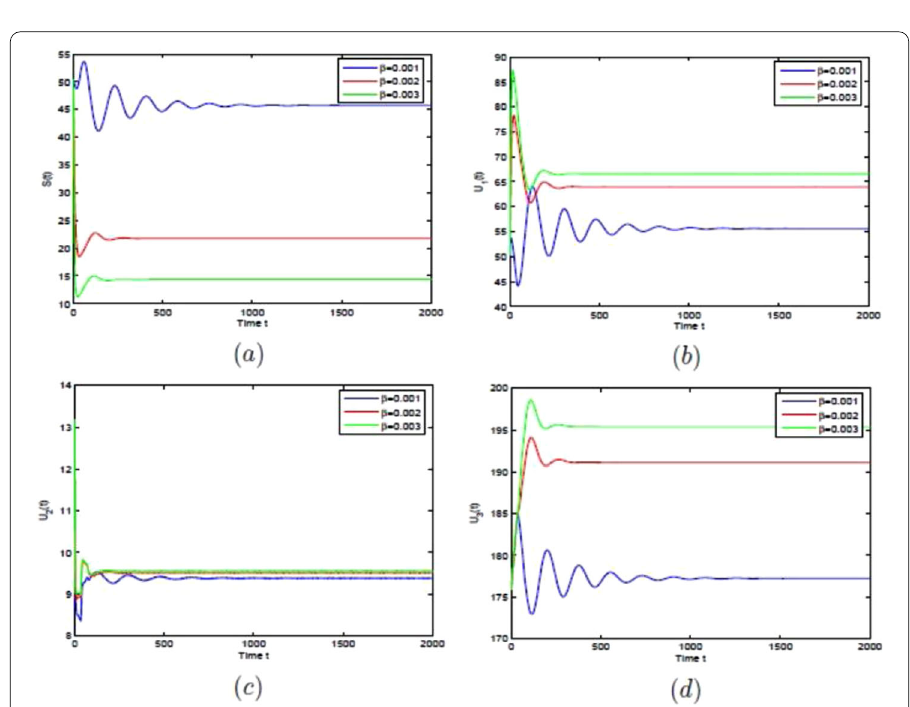
Figure 7 Effect of β on all classes for τ = 35.25: ( a ) S , ( b ) U 1 , ( c ) U 2 , ( d ) U